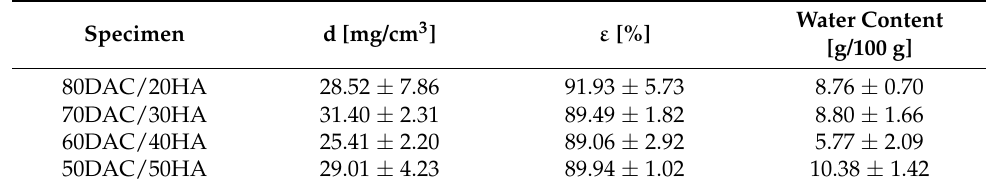
Table 2. The results of density (d), porosity ( ε ) and water content of dialdehyde chitosan/hyaluronic acid scaffolds.